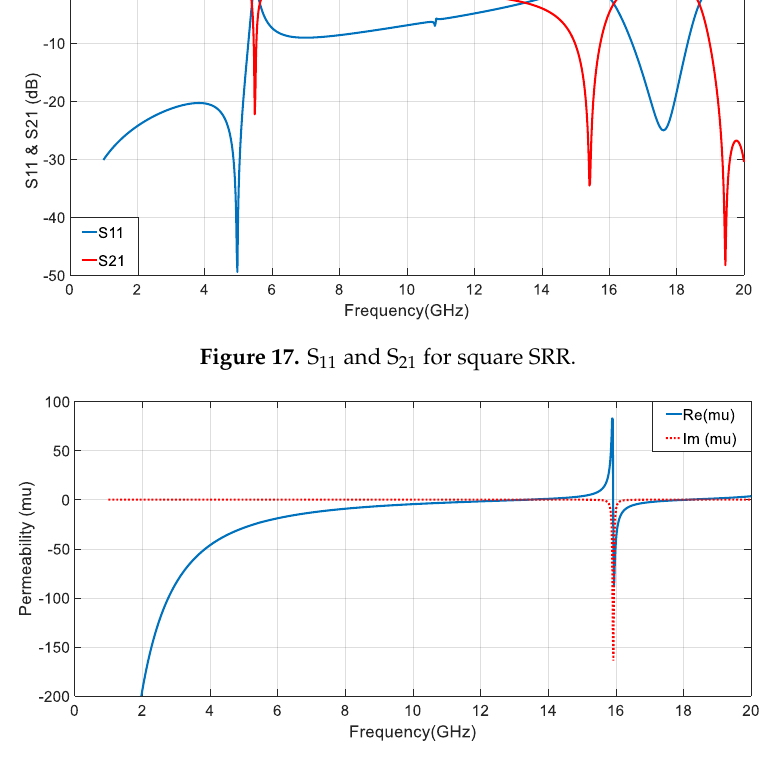
Figure 18. Real and imaginary effective permeability µ.